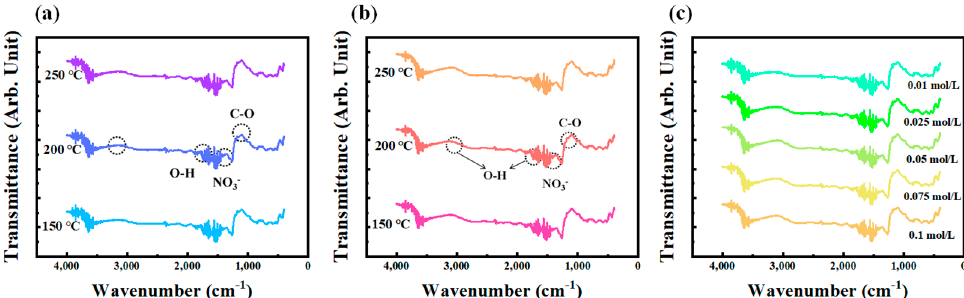
Figure 3. ( a ) films with plasma treatment; ( b ) Zr–AlO x films with 0.05-mol/L concentration under different annealing temperatures; ( c ) Zr–AlO x films annealed under 250 °C with different doping concentrations.